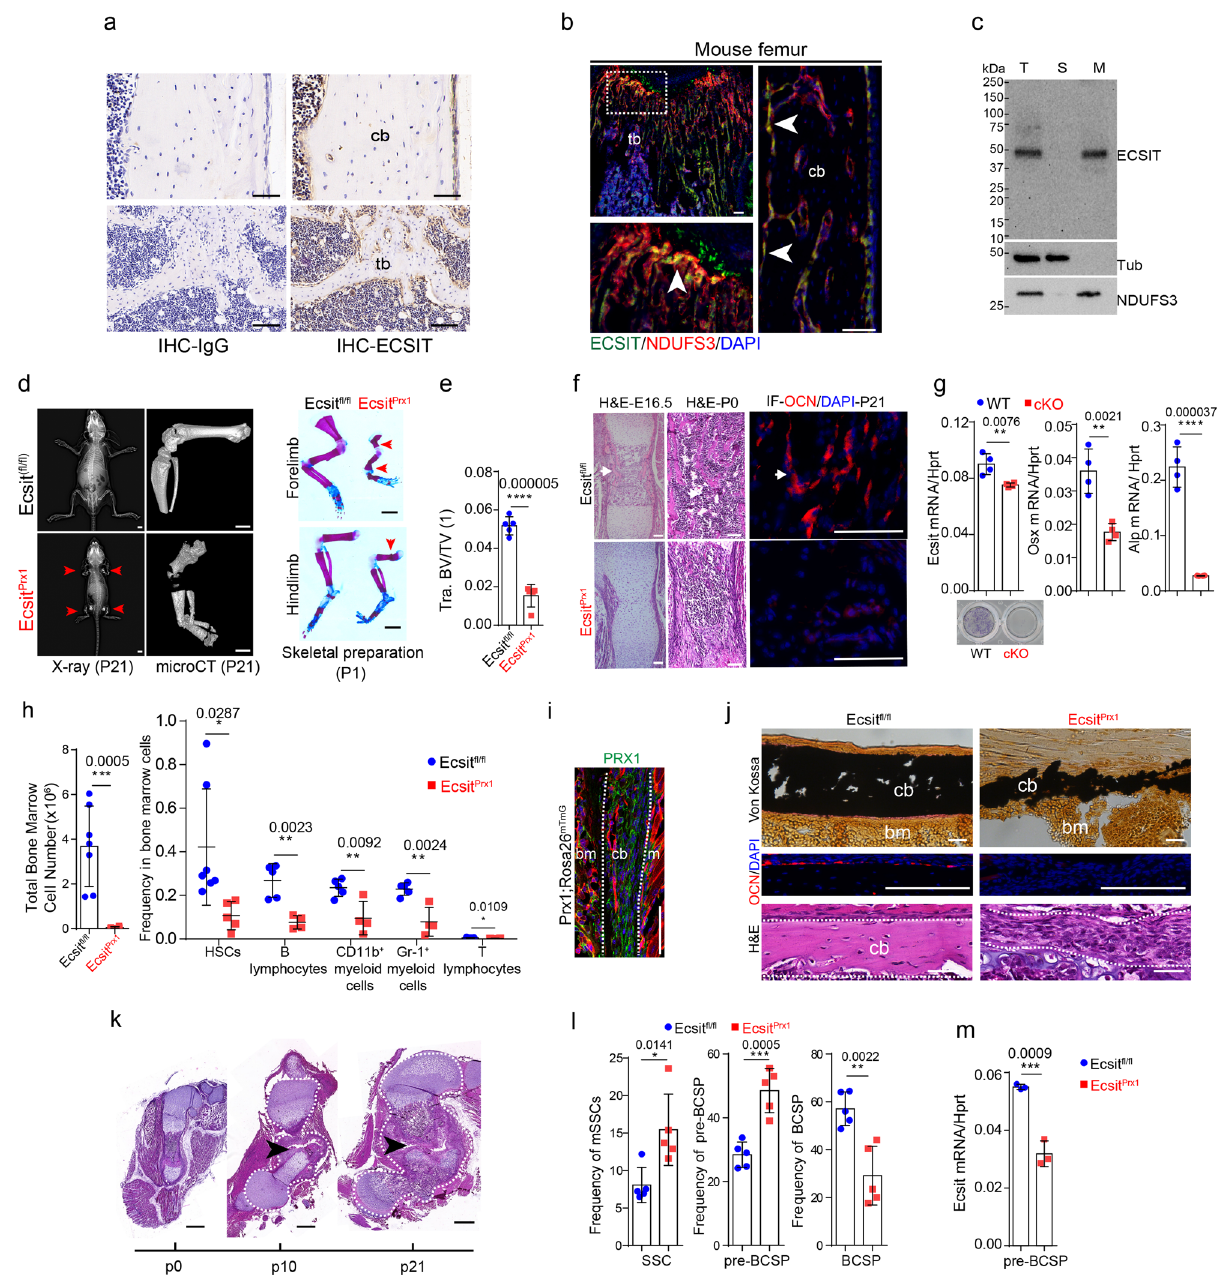
Fig. 1 | Ecsit Prx1 mice show defects in skeletogenesis, fracture healing, and the bone marrow niche.a Immunostaining of ECSIT in 2-month-old wild-typefemurs. tb: trabecular bone, cb: cortical bone. b Immuno fl uorescence showing the locali- zation of ECSIT in P21 mouse femurs. Arrows indicate co-localization of ECSIT and NDUFS3. c . Immunoblot analysis showing mitochondrial fractionation of ECSIT in human BMSCs. d , e X-radiography ( d , left ) and microCT showing P21 whole body and hindlimbs ( d , middle ) and quanti fi cation of femoral bone mass ( e , n =5). Ali- zarin red/alcian blue staining of P1 neonates ( d , right ). Arrows indicate sponta- neous fractures. Tra. BV/TV: Trabecular bone volume/total volume. f H&E staining of E16.5 and P0 femurs ( left , middle ). Immuno fl uorescence showing osteocalcin (OCN) expression in the femurs ( right ). Arrows indicate femoral trabecular bone. g Skeletal progenitors isolated by FACS from P0 Ecsit; Prx1 Rosa26 mTmG (cKO) and Prx1;Rosa26 mTmG (WT) limbs using GFP + CD45 − Ter119 − Tie2 − markers. Osteogenic geneexpression( n =4)andalkalinephosphataseactivity(ALP, n =3)wereassessed forosteogenicdifferentiation. h Flowcytometryanalysisshowing frequencyofthe